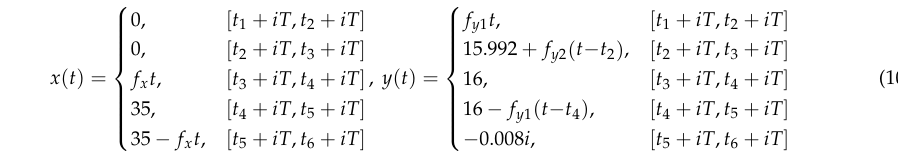
Figure 13. Time-domain vibration measurement results in the vertical direction.